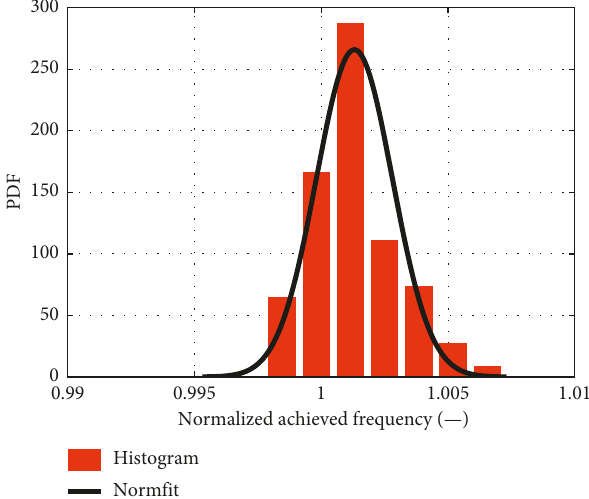
Figure 8: PDF of normalized achieved bouncing frequencies for all participants for the reference configuration at 1.8Hz.